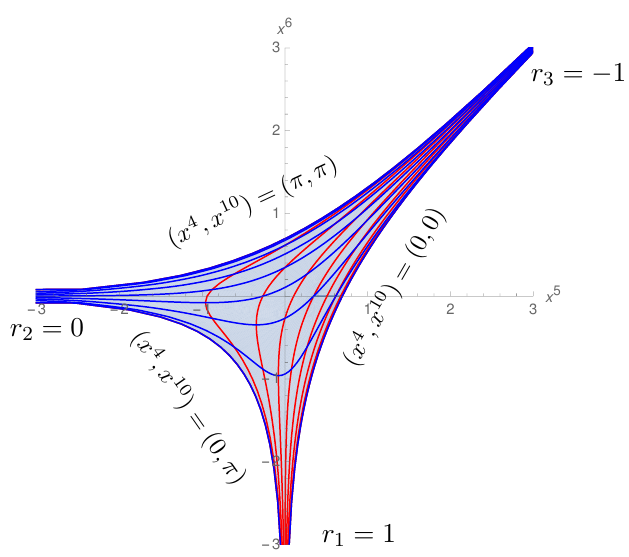
Figure 2. T 1 curve with ~ R 4 = R 10 = 1 obtained by embedding (cid:6) IIB into M 4 via (3.8). The poles r ‘ on (cid:6) IIB correspond to the external 5-branes in the asymptotic regions as indicated. The segments of the boundary @ (cid:6) IIB in between poles are mapped to the outer curves connecting the asymptotic regions, with values of x 4 , x 10 as indicated. The blue curves correspond to constant x 4 , the red curves to constant x 10 . Both are positive for w 2 (cid:6) IIB . The embedding of the second half of ^(cid:6) IIB , with w in the lower half-plane, is obtained by reversing the signs of x 4 and x 10 (3.16). The coe(cid:14)cients which are not (cid:12)xed by the boundary conditions (4.2) are tuned to